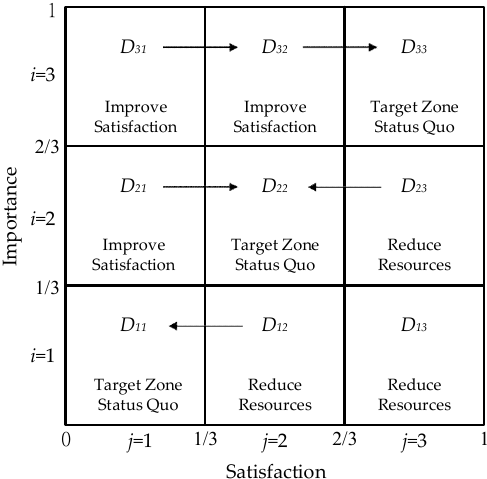
Figure 3. Performance Evaluation Matrix (PEM) [26].